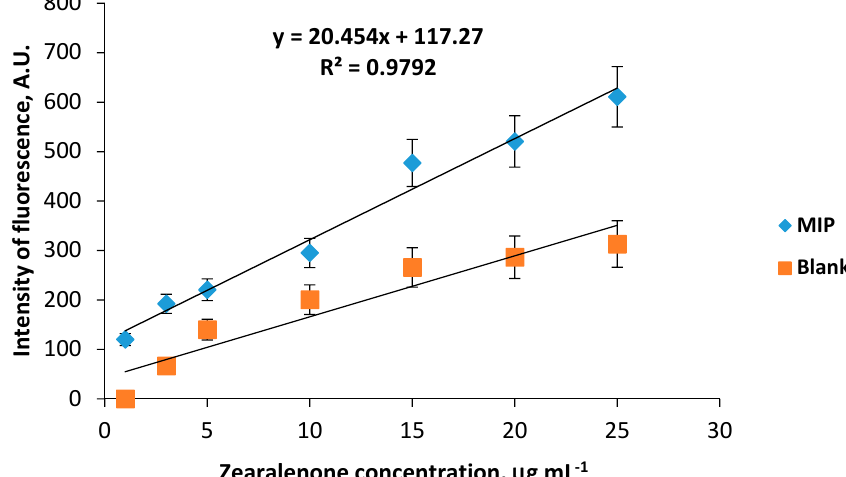
Figure 6. Calibration graphs of zearalenone-selective fluorescent sensor based on CDHB-imprinted (MIP) and reference (blank) 1-allylpiperazine-containing membranes (working solution 20 mM Na-phosphate buffer, pH 6.0, containing 150 mM NaCl, 10% acetonitrile and 1–25 µg mL − 1 zearalenone). Differential sensor response is a residual between sensor signals obtained by fluorescent sensors based on MIP and corresponding reference polymeric membranes.